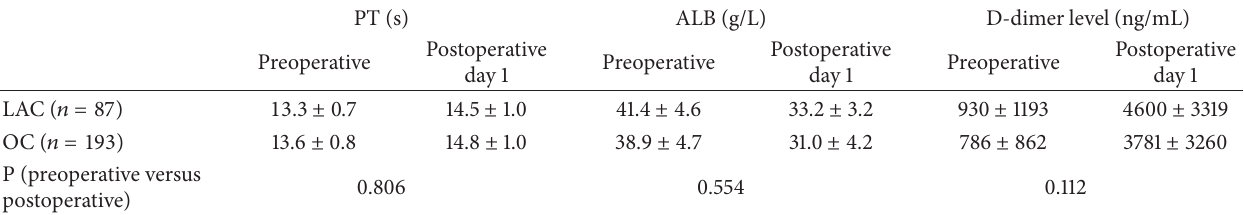
Table 5: Comparison of perioperative prothrombin time (PT), serum albumin (ALB), and D-dimer levels between the